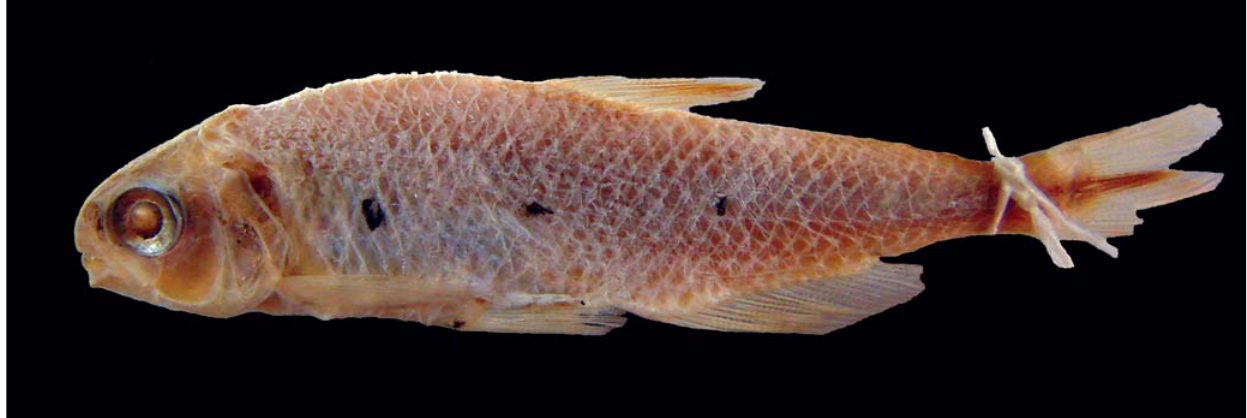
Fig. 25. Hemibrycon tridens , CAS 44358, holotype, 51.5 mm SL, male, upper río Ucayali basin, Peru. The black marks are preservation